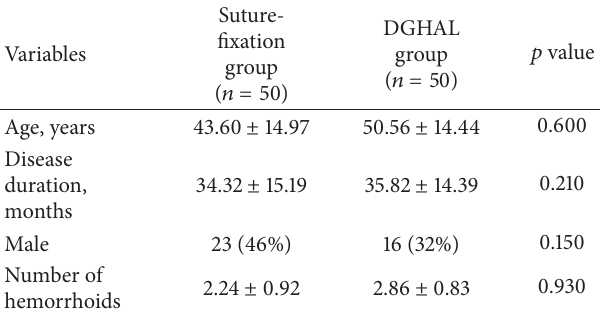
Table 1: Demographics and clinical characteristics of study subjects.